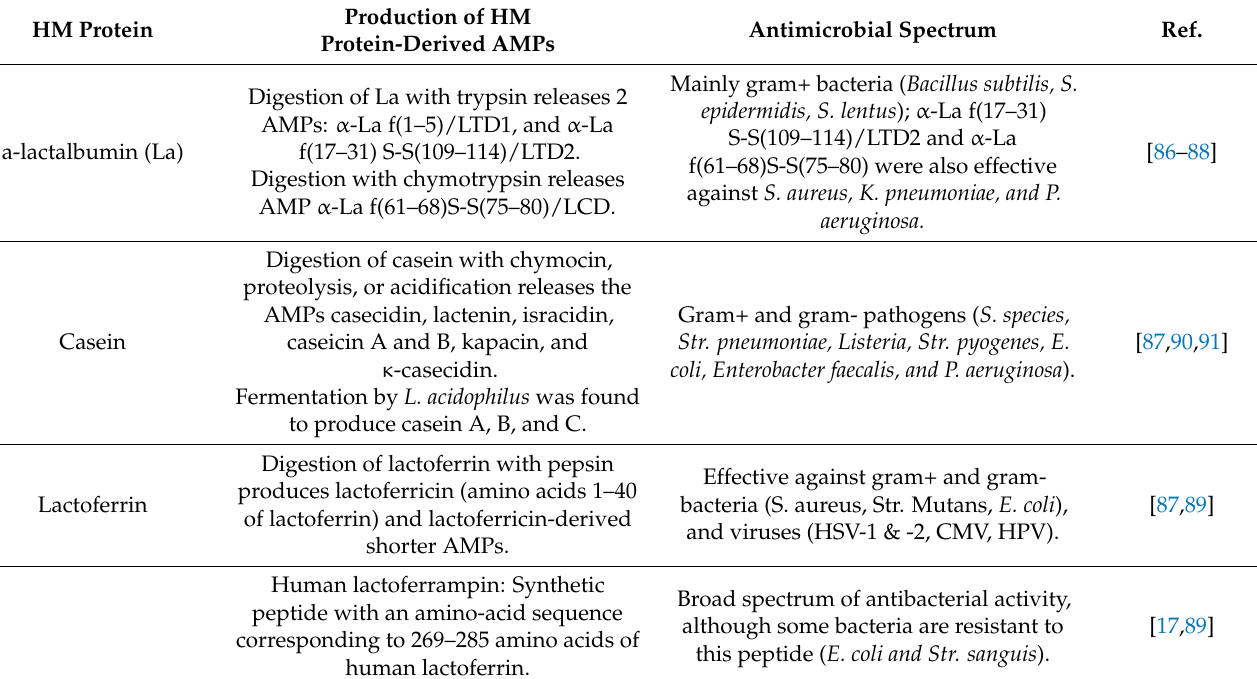
Table 2. Antimicrobial peptides derived from human milk